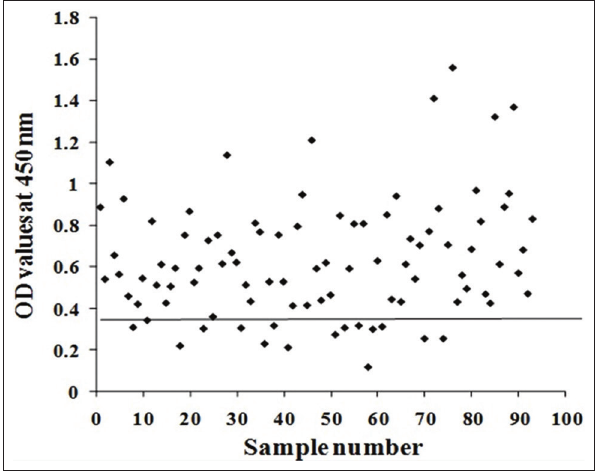
Figure-4: Diagnostic potency of FI in collected camel random serum